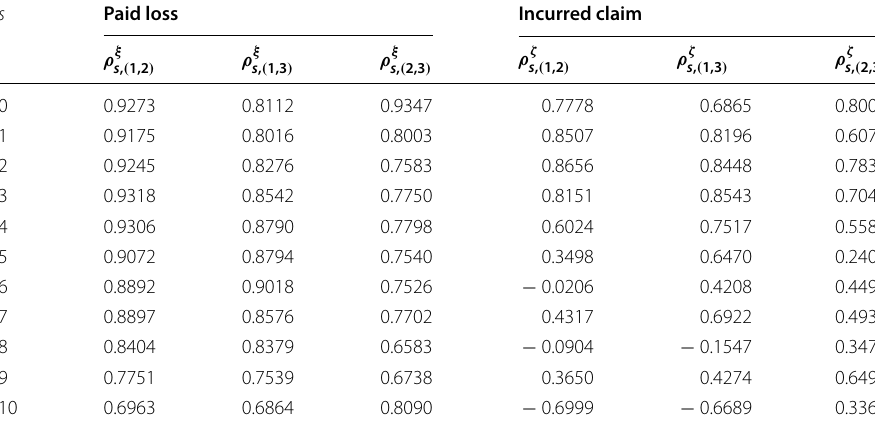
Table 6 Correlation between different